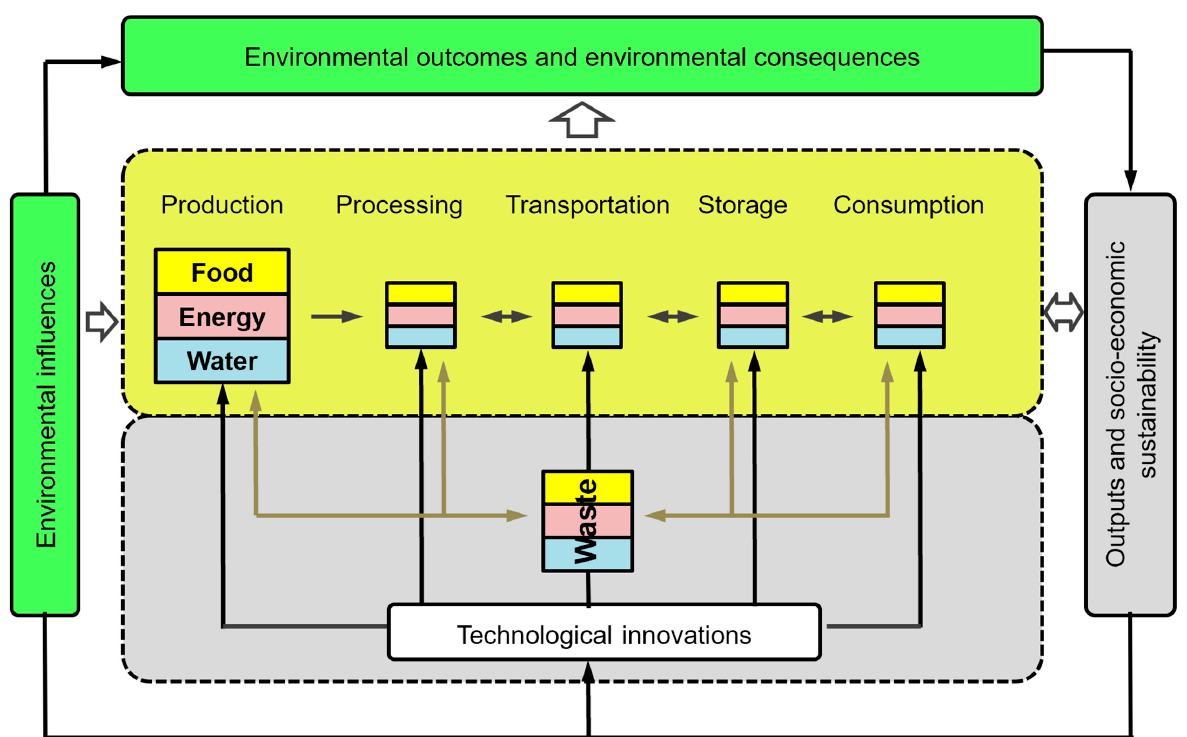
Figure 7. A research enterprise framework for prioritizing FEW interactions with environmental (green), economic (yellow) and societal (grey) systems (adapted after [49]). (green), economic (yellow) and societal (grey) systems (adapted after